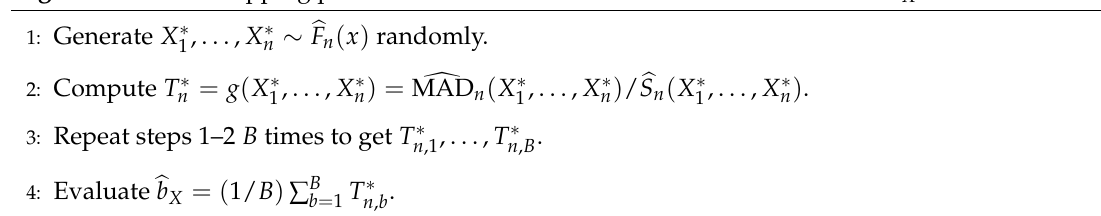
Algorithm 1 Bootstrapping process used in order to obtain the consistent factor b X